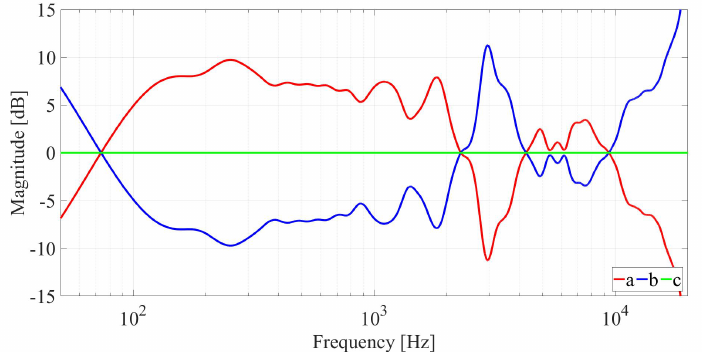
Figure 11. Equalization results: the spectral deviation measures the distance between the equalized response curve and the flat one: (red) H ( e j ω ) , (blue) H inv ( e j ω ) , (green) E ( e j ω ) = H ( e j ω ) · H inv ( e j ω )